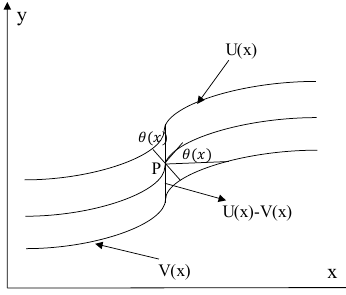
Figure 9. Diagram of continuous curve spacing.